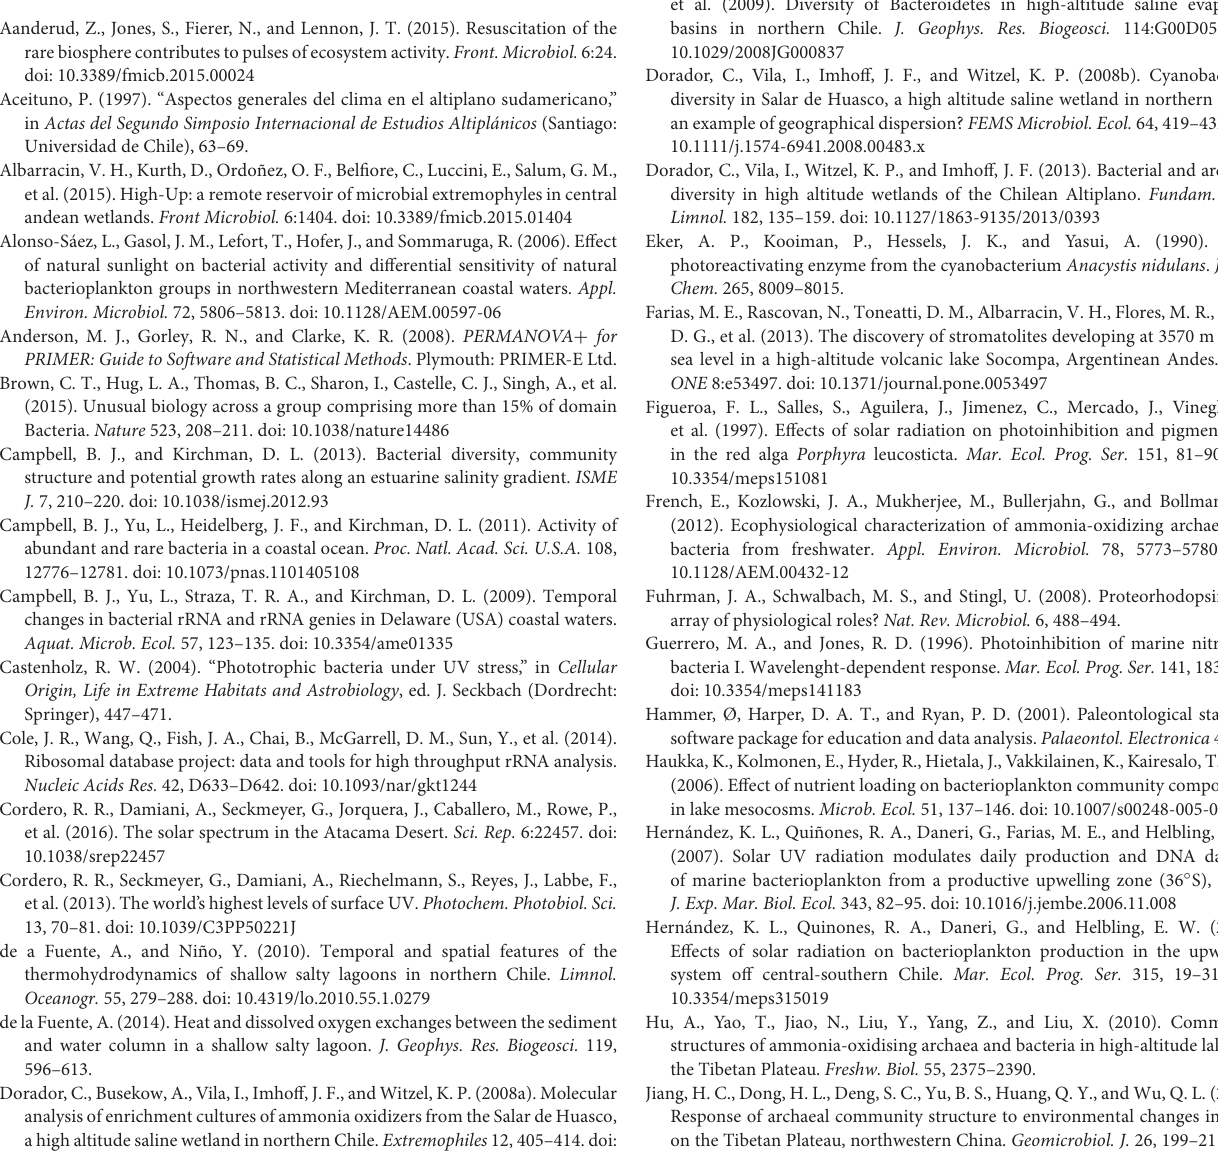
FIGURE S2 | Rarefaction curves derived from classified active bacteria OTUs detected from the 16S rRNA pyrolibraries (cDNA) generated from samples collected in situ and the following experimental incubation treatment. Treatments acronyms: FS (full sun treatment between 280–700 nm), Dark (cover by aluminum foil and black plastic bags), PAR (400–700 nm, Photosynthetically Active Radiation), and PA (320–700 nm, UVR and PAR). TABLE S1 | Pyrolibraries information, including coverage (Chao1), ecological indexes (OTU and Shannon H (cid:48) ), and Phyla changes through the incubations depicted by gray gradients as abundant ( > 0.5%, semi-rare 0.5–0.1%, and rare < 0.1%). Treatments acronyms: FS (full sun treatment between 280–700 nm), Dark (cover by aluminum foil and black plastic bags), PAR (400–700 nm, Photosynthetically Active Radiation), and PA (320–700 nm, UVR and